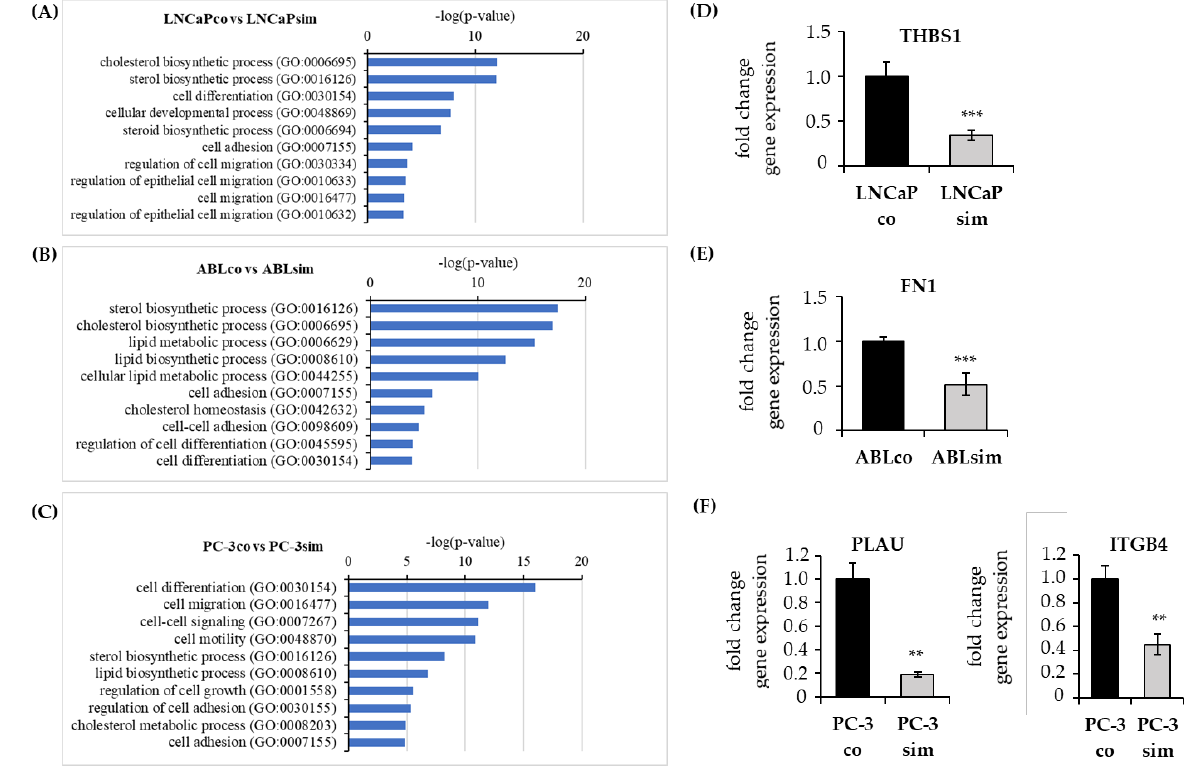
Figure 6. Changes in the expression of genes related to cell migration and cell adhesion. ( A – C ) Top 10 significantly regulated pathways as identified through GO pathway analysis. Expression of ( D ) thrombospondin-1 ( THBS1 ), ( E ) fibronectin ( FN-1 ), ( F ) urokinase plasminogene activator ( PLAU ), integrin subunit beta 4 ( ITGB4 ), and urokinase plasminogene activator ( PLAU ) annotated to “cell adhesion” and “cell migration” was determined in long-term simvastatin-treated cells through real-time qPCR and compared to parental control cells. Data are represented as mean ± SEM. (** p < 0.01, *** p < 0.001). Overall, these data suggest that despite the acquired insensitivity of long-term simvastatin-treated cells to statins and the significant increase in the expression of cholesterol pathway genes, these cells are presumably affected in their cell adhesion and migration abilities. Based on this assumption, we next investigated the migration capacity of simvastatin-treated cell lines using a FluoroBlok migration assay. As shown in Figure 7A, all three cell lines exhibited a significantly reduced migration capacity compared to their parental controls. The effect was again most pronounced in PC-3sim cells. In general, PC-3co cells had a higher percentage of migrating cells than LNCaPco and ABLco cells. ABLsim cells also had a reduced migration capacity compared to ABLco cells; however, these cells migrated weakly compared to LNCaP and PC-3 cells. Since PC-3 cells are derived from a bone metastasis, we next investigated their migration towards differentiated osteoclasts (OC). To this end, human THP-1 monocytes were cultured with PMA, RANKL, and M-CSF over 9 days in the lower chamber as described under material and methods. Then, PC-3co and PC-3sim cells were seeded into fluoroblok transwell inserts, which were added to the wells with osteoclasts of the companion plate. After another 72 h, the migration of PC-3co and PC-3sim was determined by calcein staining of the insert. As shown in Figure 7B, the percentage of migrated cells towards osteoclasts was significantly lower in PC-3sim cells compared to the parental PC-3co cells (Figure 7B),